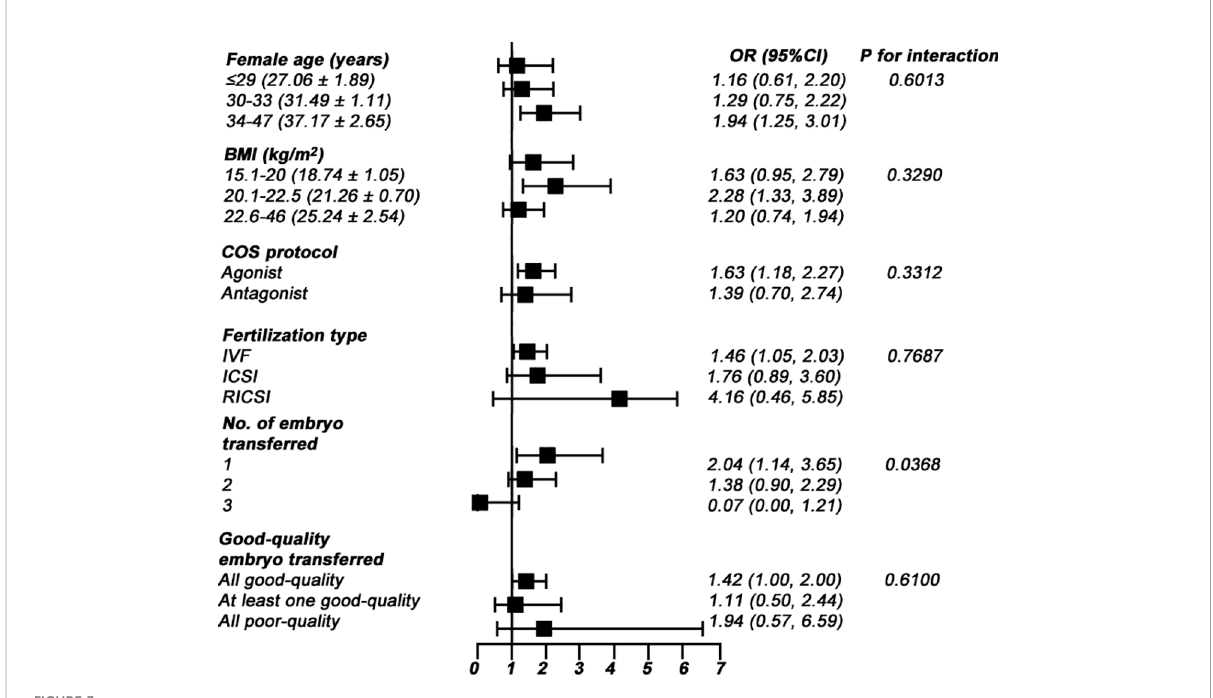
FIGURE 3 Subgroup analyses for the effect of FOI on CPR.